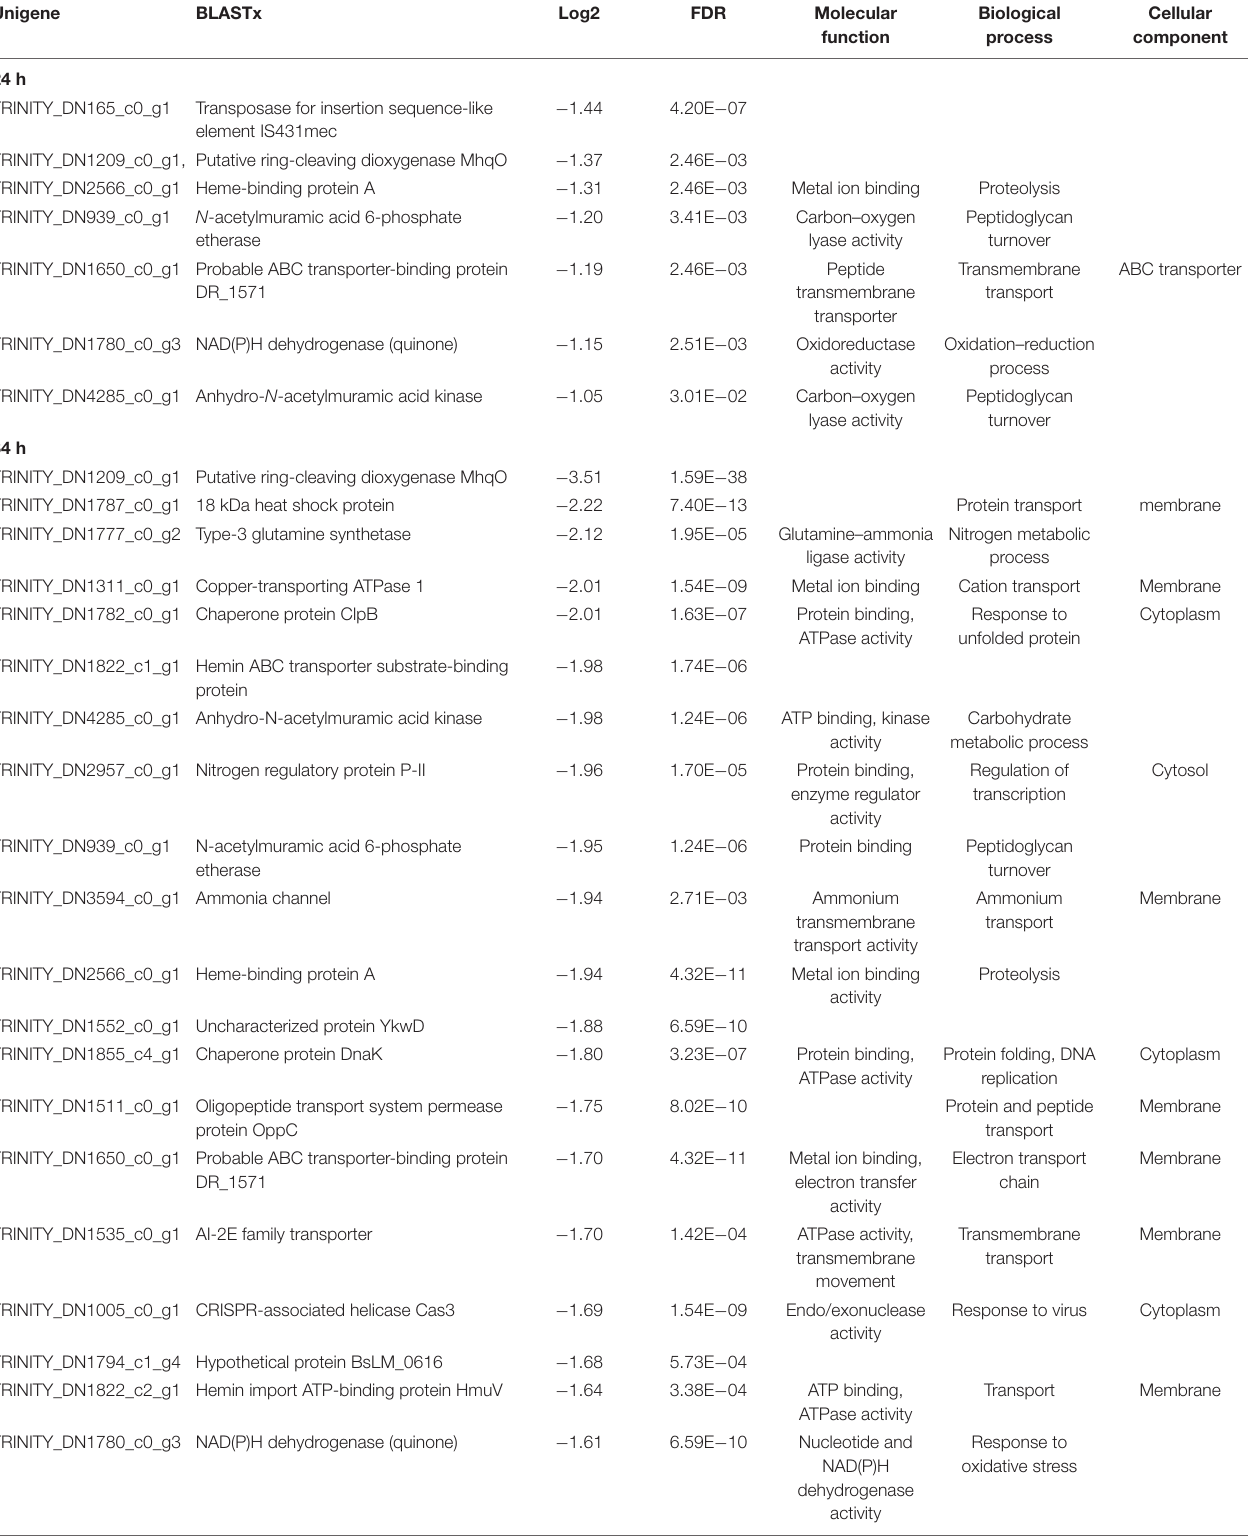
TABLE 1 | Significantly regulated D. radiodurans unigenes when grown under below background ionizing radiation. Unigene BLASTx Log2 FDR Molecular